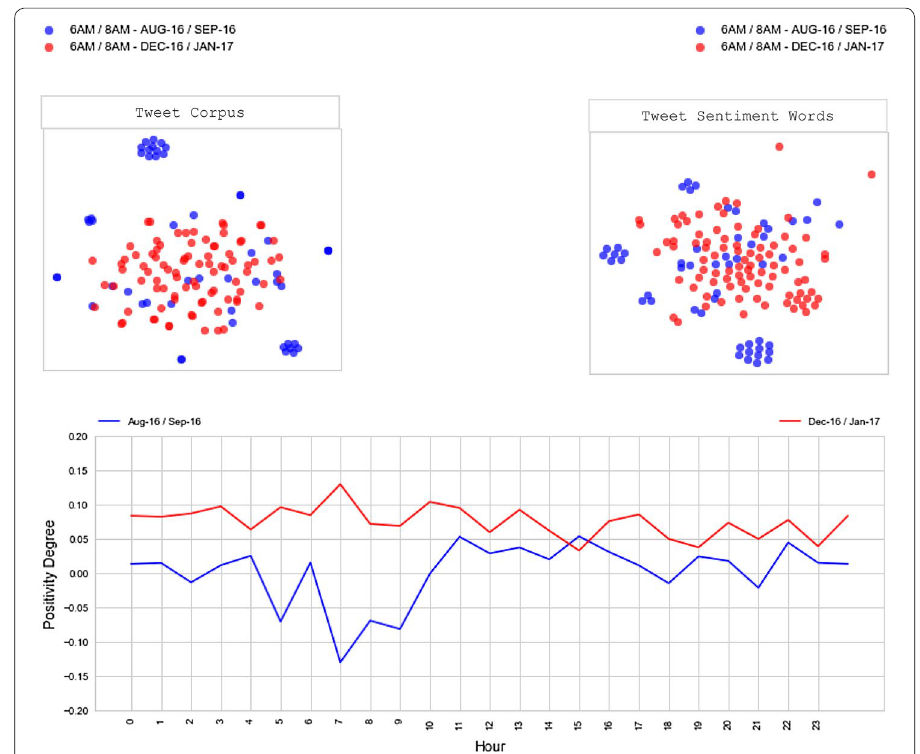
Fig. 4 Sentiment variation by time/bimester (all bimesters) (Source: prepared by the